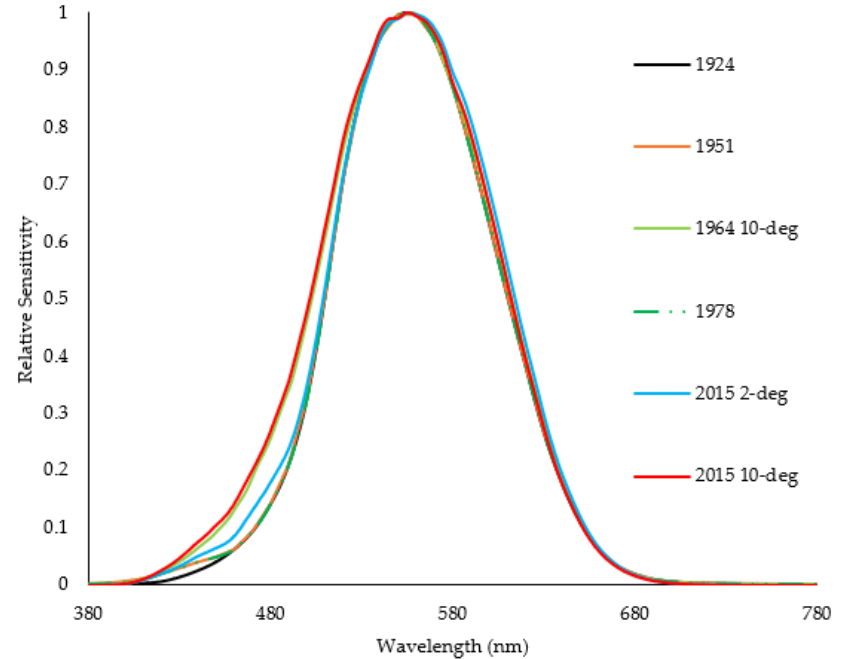
Figure 1. The CIE 1924 (black continuous line), 1951 Judd (brown continuous line), CIE 1964 10-degree (light green continuous line), 1978 Vos (green dashed line), CIE 2015 2-degree (cyan continuous line), and CIE 2015 10-degree (red continuous line) spectral luminous efficacy functions. Buildings 2022 , 12 , x FOR PEER REVIEW